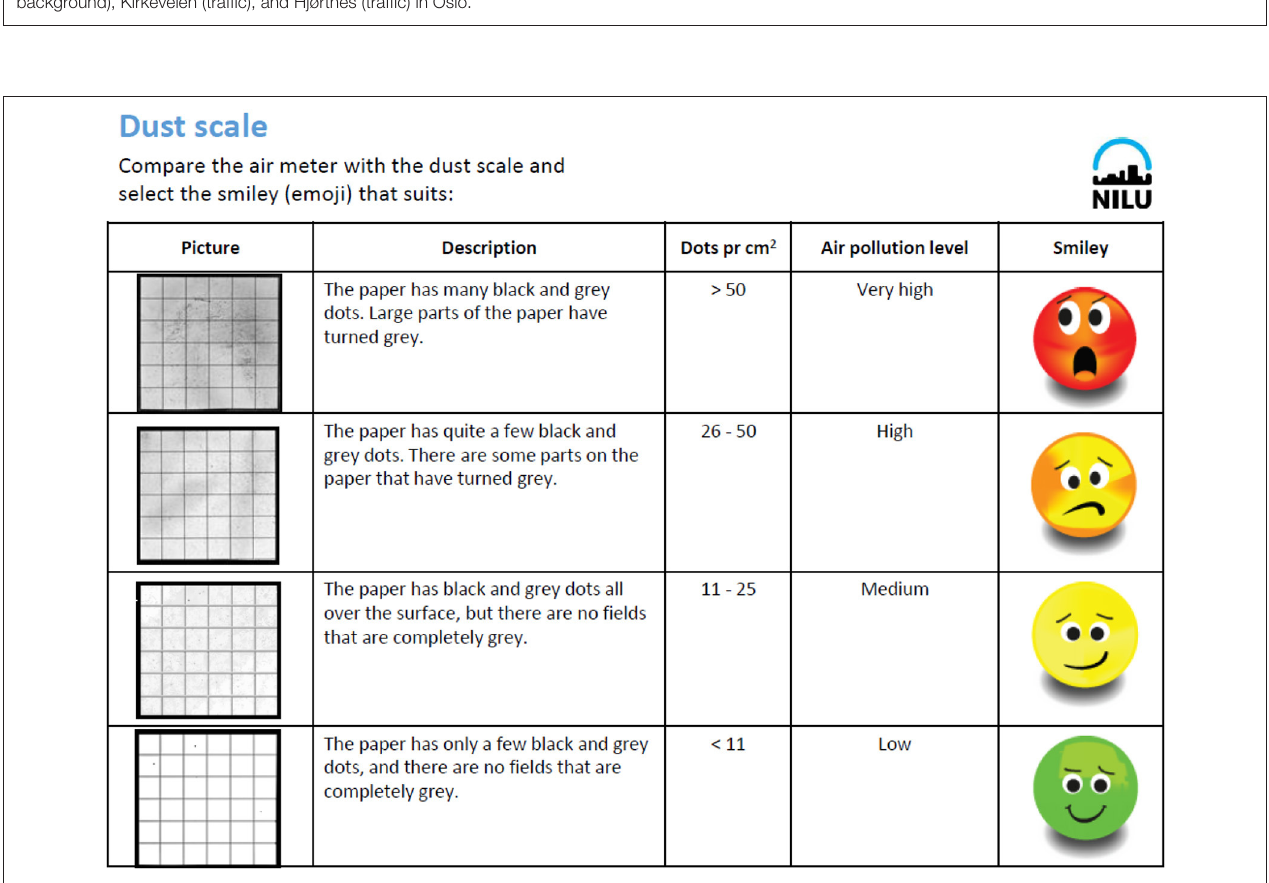
FIGURE 4 | Dust scale to obtain the air pollution level measured with the air meter. Each level is associated with one smiley. The smiley will be used in the website to represent the air pollution level.